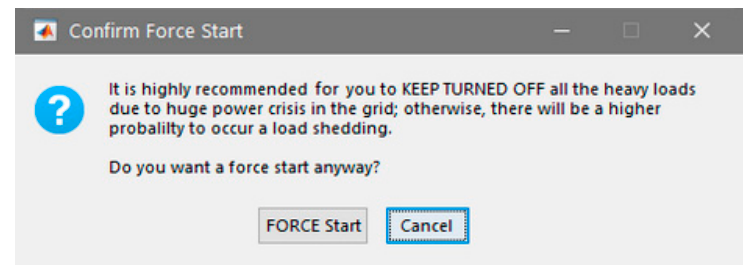
Figure 20. Additional Force Start option generated to notify the consumer.